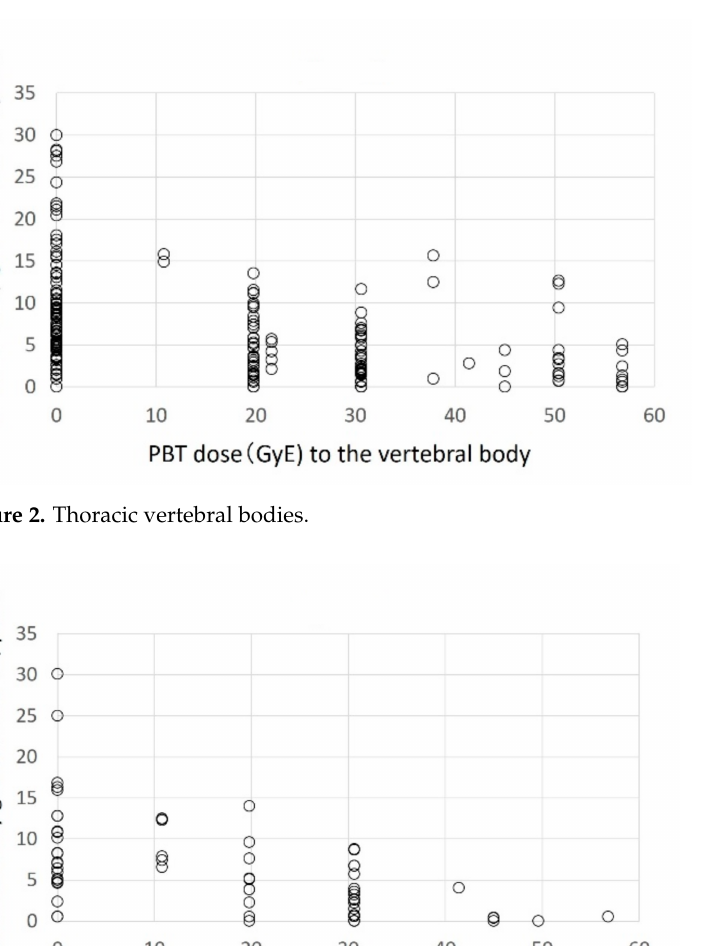
Figure 1. Scatter plot of the growth rate (%/year) of cervical vertebral bodies and proton beam therapy dose.